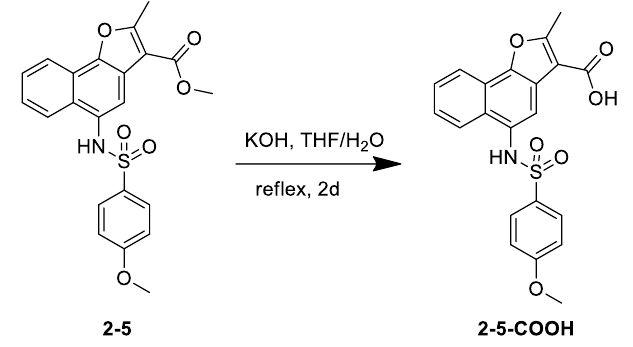
Scheme 1. Hydrolysis route of Compound 2-5 to Compound 2-5-COOH . Table 5. IC 50 for compounds measured on two TNBC cell lines.